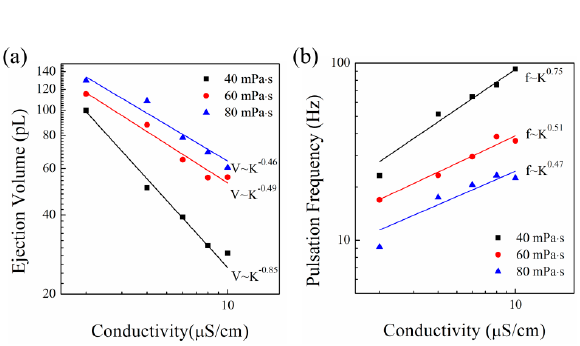
Figure 3. The ejection volume and pulsation frequency for liquids with different conductivities: ( a ) the relation of ejection volume and conductivity; ( b ) the relation of pulsation frequency and conductivity. The applied voltage was 2150 V. The nozzle-to-substrate distance was 1.5